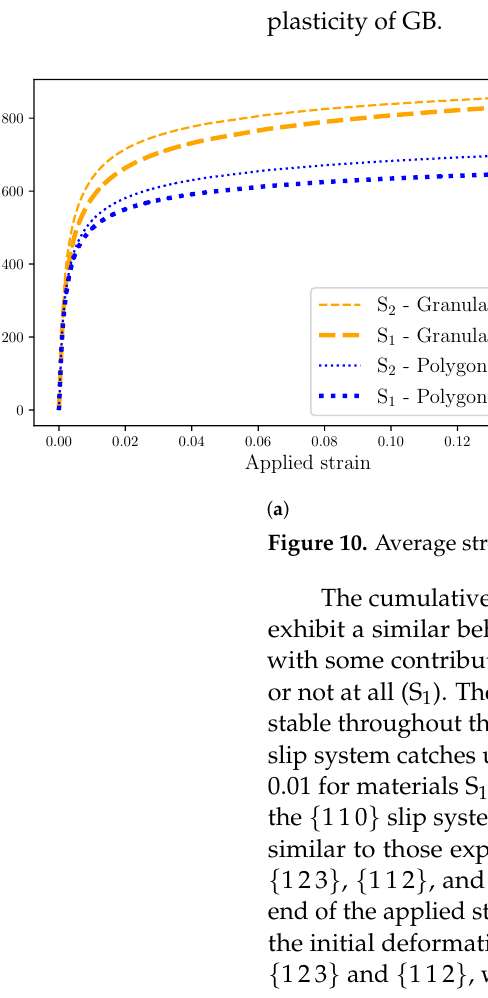
it was shown that a lower bainitic fraction was associated with a delay in the onset of the plasticity of GB.